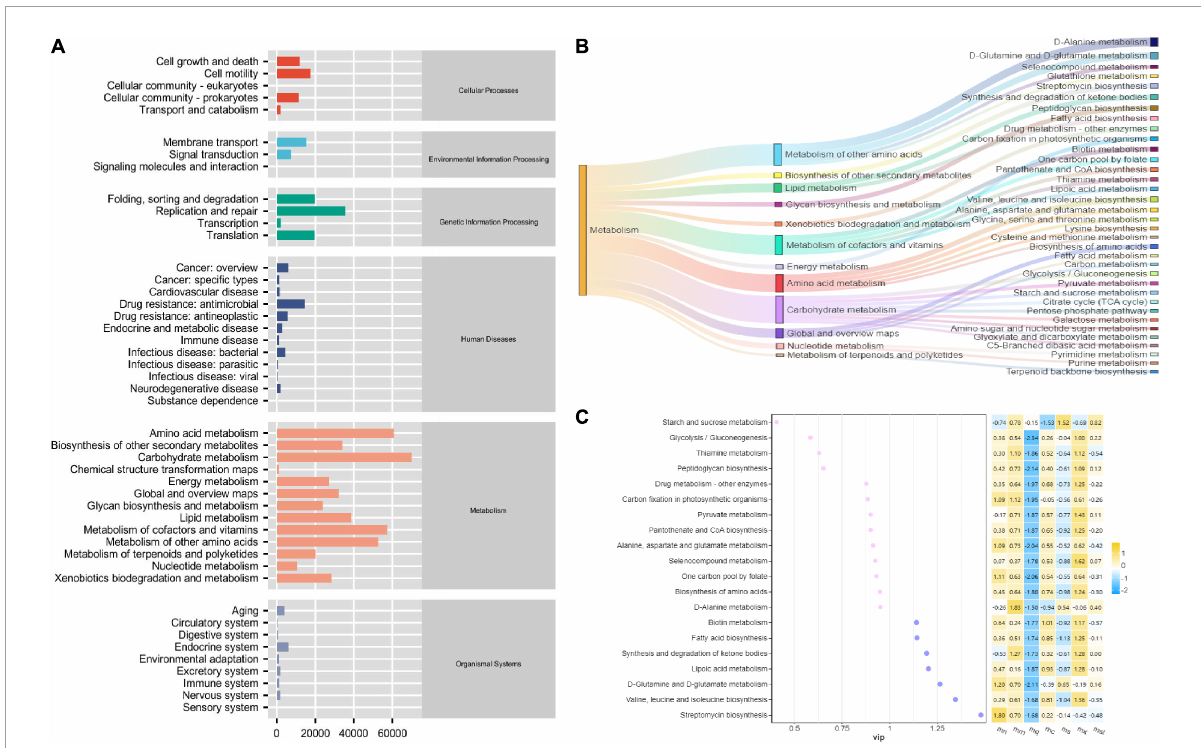
FIGURE6 PiCRUSt-based examination of the gut microbiome of the different sweeteners. (A) Predictive abundance diagram of function. (B) Sankey diagram. (C) Point stick heat map.